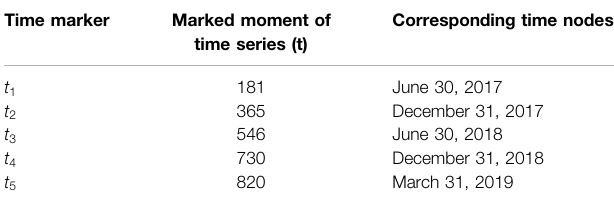
TABLE 2 | Markers of the fi ve special time nodes for investigation of the TSRNN model performance. Time marker Marked moment of Corresponding time nodes time series (t)